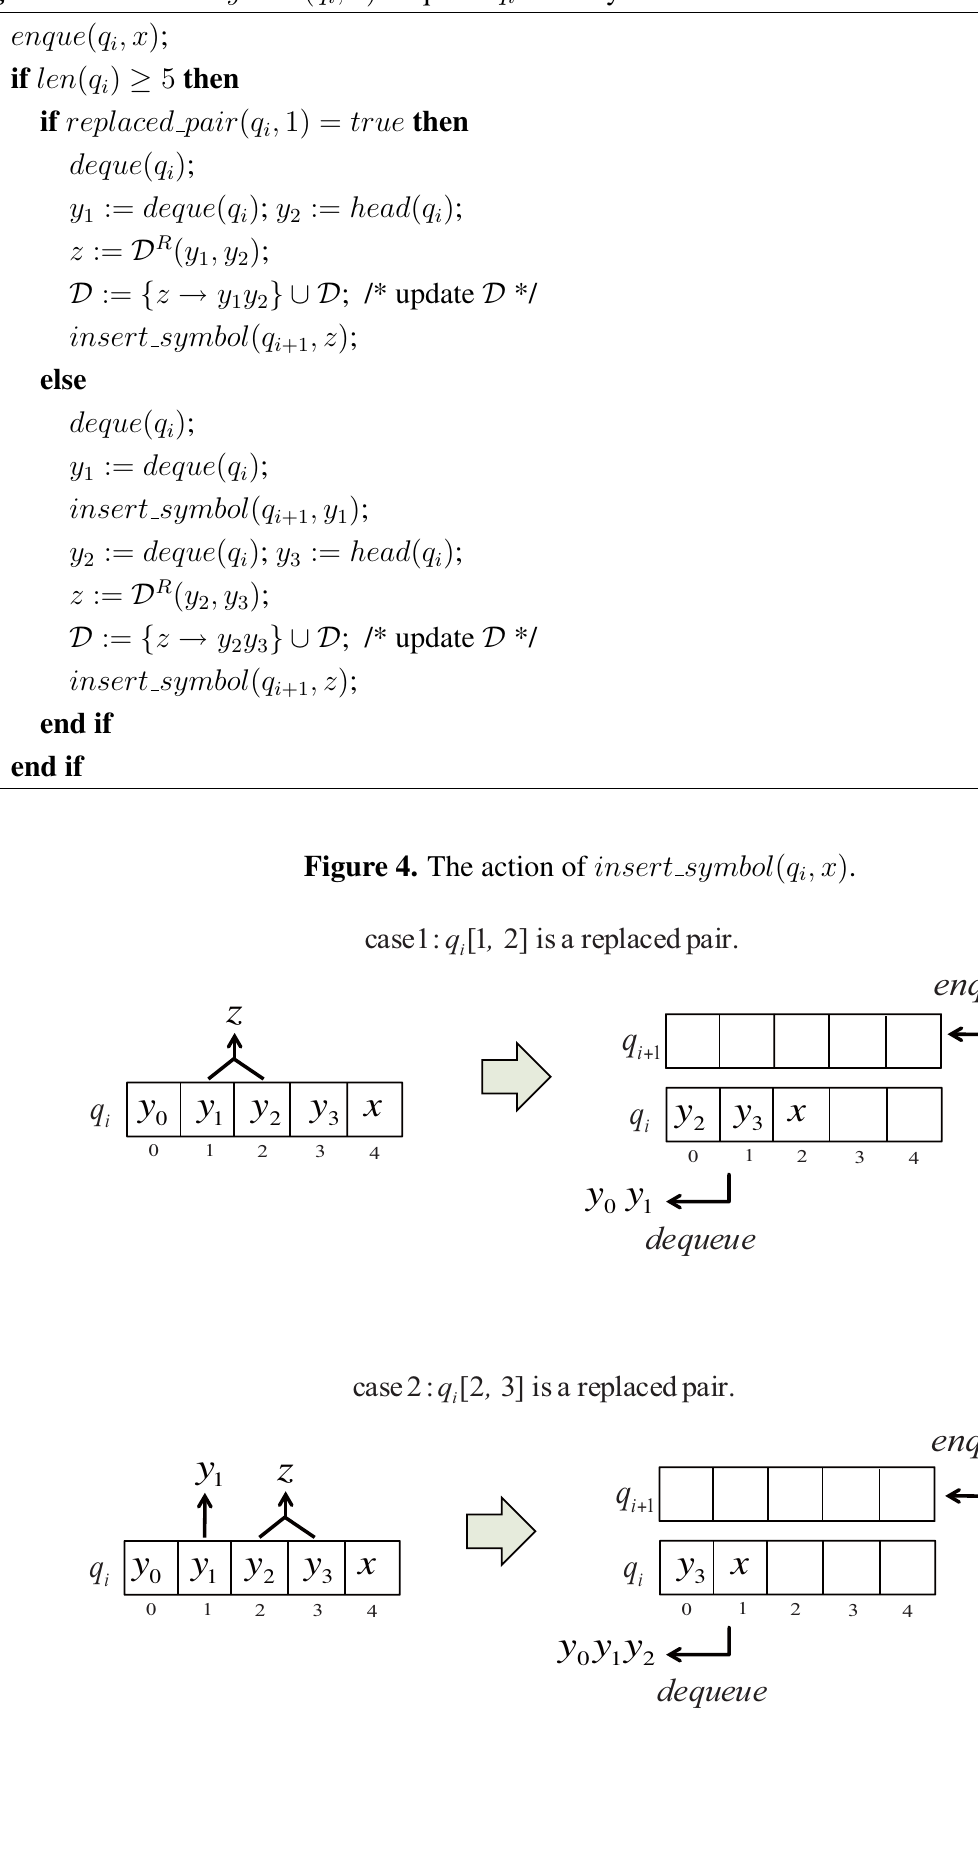
Algorithm 3 insert symbol ( q